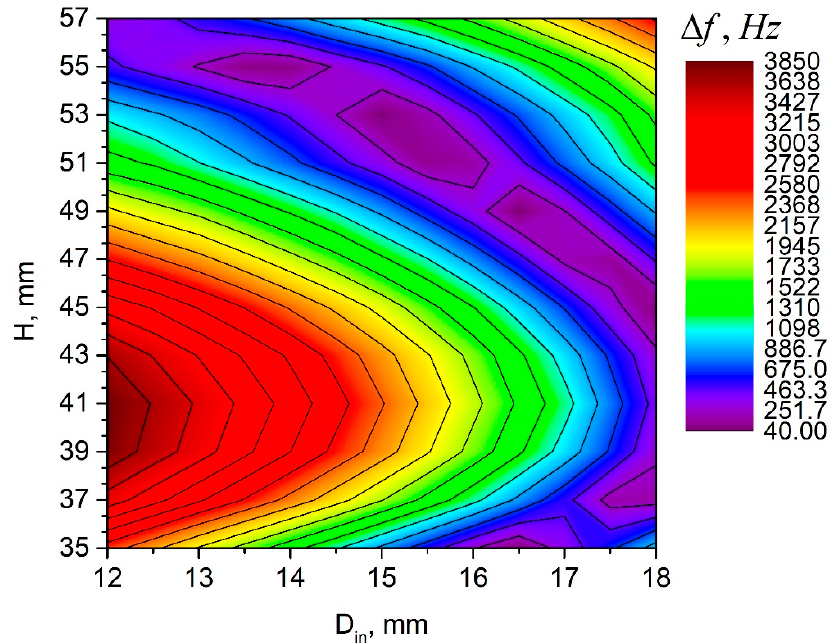
Figure 2. Dependence of the difference between the natural frequencies of the first longitudinal and second bending vibration modes on the diameter of the hole and height of the cylinder.